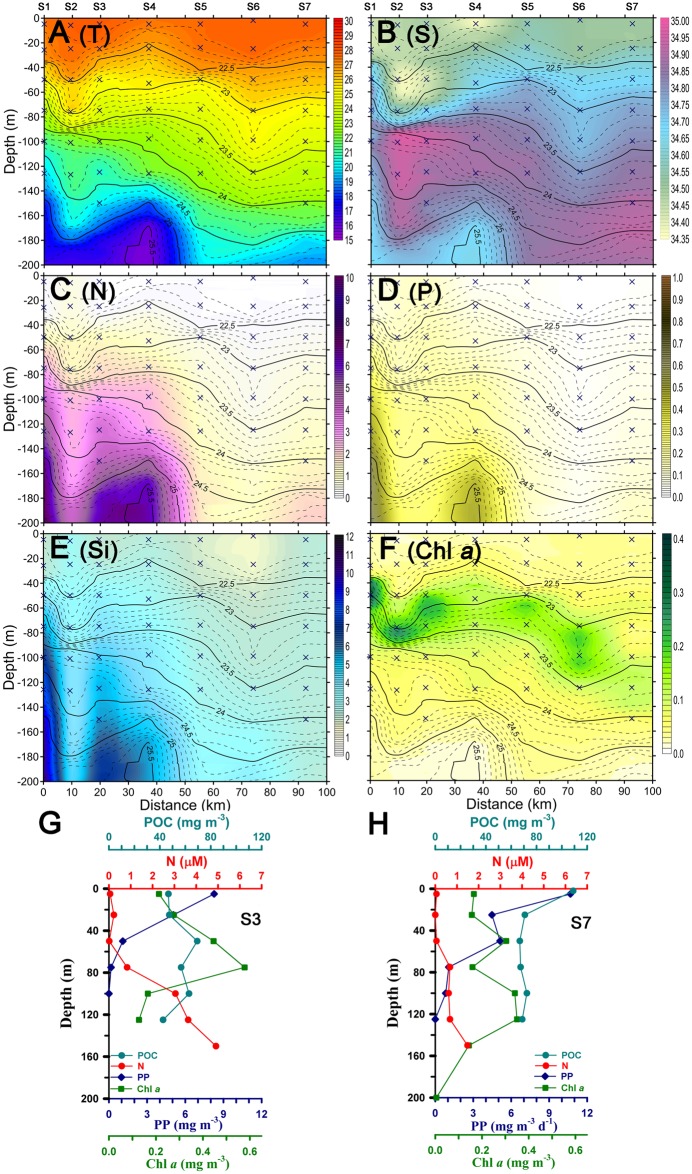
The contoured profiles at S1–S7 and vertical distributions ofbiogeochemi- cal parameters at S3 and S7.Contours of (A) potential temperature (°C), (B) salinity, (C) nitrate + nitrite (N, μM), (D) phosphate (P, μM) (E) silicate (Si, μM) and (F) Chl a (mg m−3), and vertical distribution of POC, N, Chl a and PP at station 3 (S3, G) and 7 (S7, H) in the WNP during cruise in 2007. Vertical cross symbols and lines in the contour depicted depths of seawater measuring and represented isopycnal layer in the upper 200m, respectively.